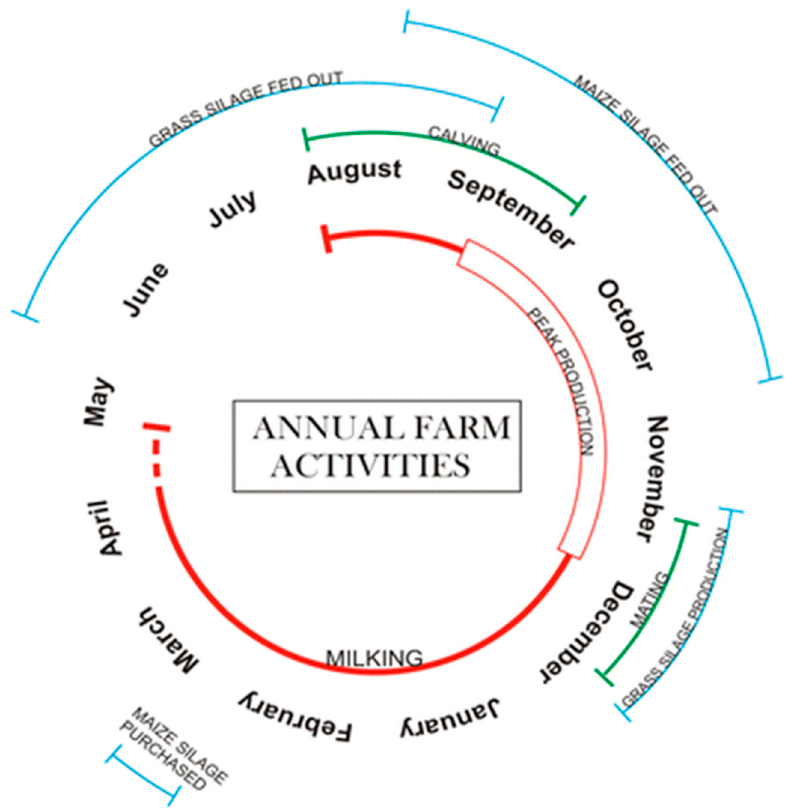
Figure 2. Annual dairy farm activities in Bay of Plenty region showing key vulnerable periods during the year of farming operations [46]. A dairy farm’s most important activities are closest to the centre, with activities of decreasing importance progressing further from the centre.